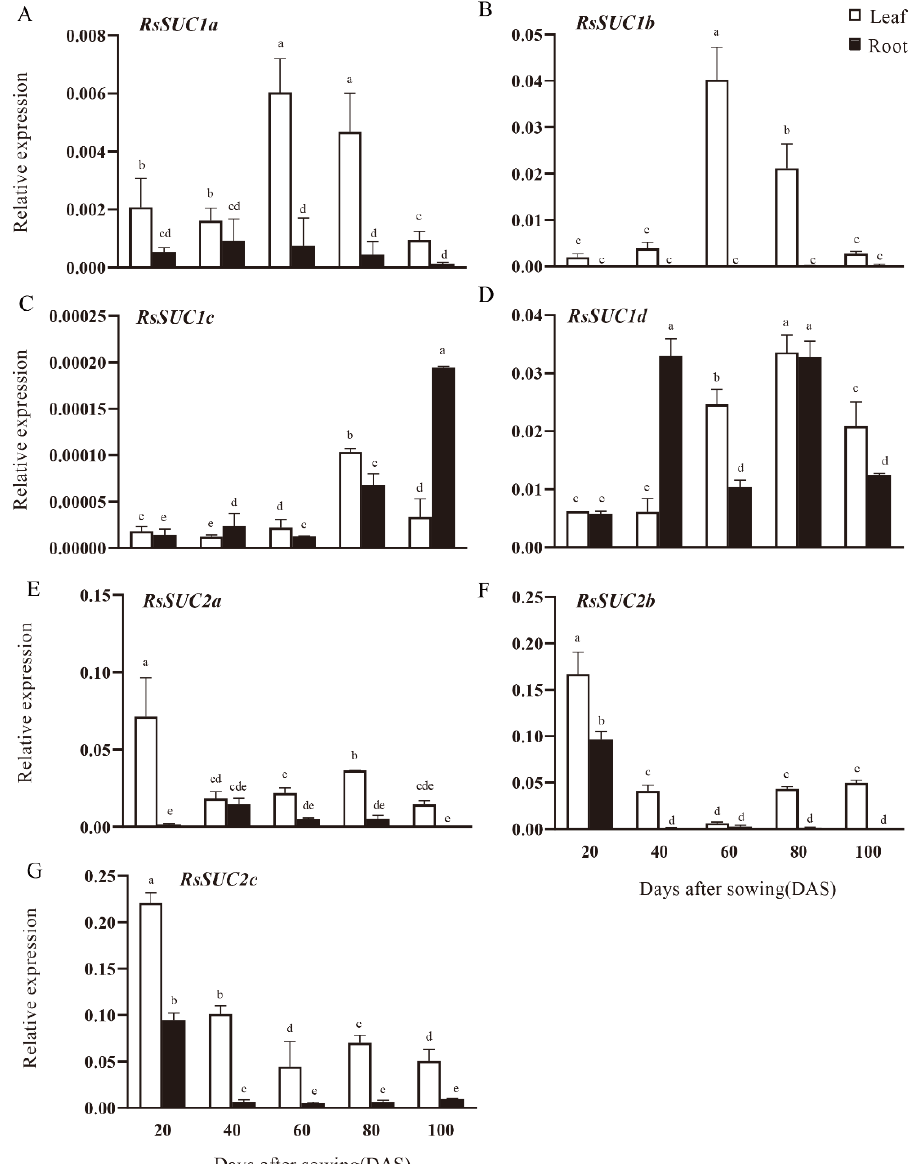
Figure 3. Expression patterns of RsSUC genes during radish development. ( A – G ) display the relative expression levels of RsSUC1a , RsSUC1b , RsSUC1c , RsSUC1d , RsSUC2a , RsSUC2b , and RsSUC2c in leaves and taproots at 20, 40, 60, 80, and 100 days after sowing (DAS), respectively. Each bar shows the mean ± SD (n = 3). Values with different letters indicate a significant difference at p < 0.05 according to Duncan’s multiple range